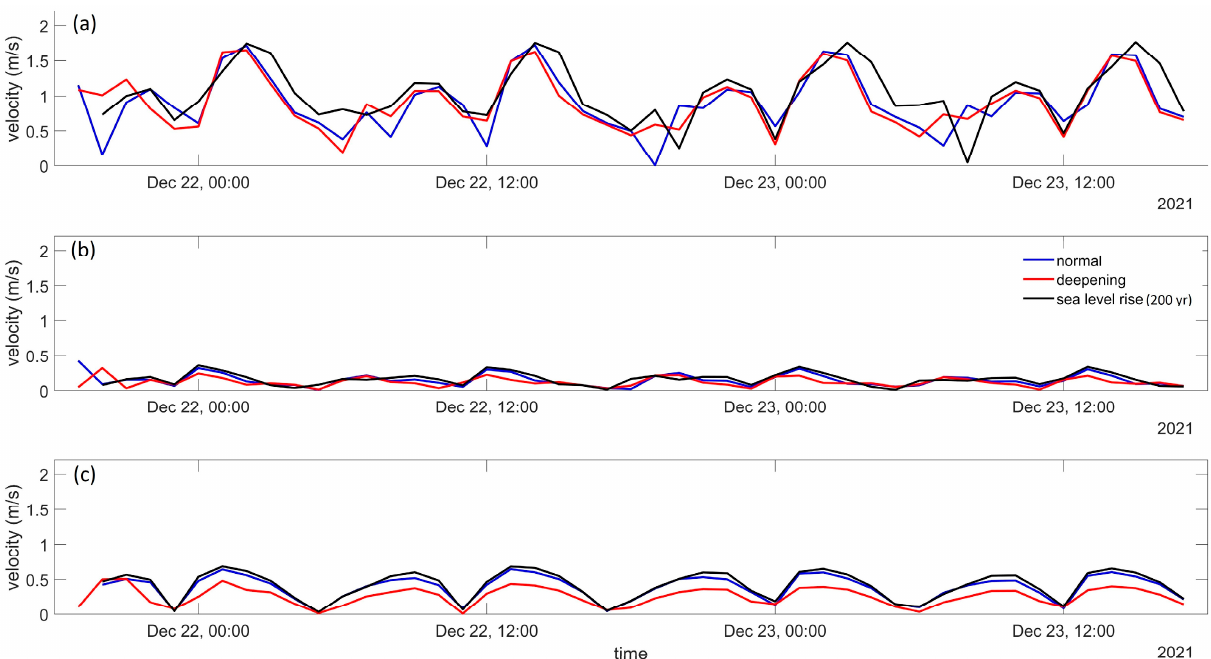
Figure 5. Modeled velocity currents at surface layer for the lowest Quadrature of 2021 in Buenaven- tura Bay of the monitoring points ( a ) A, ( b ) B and ( c ) C.